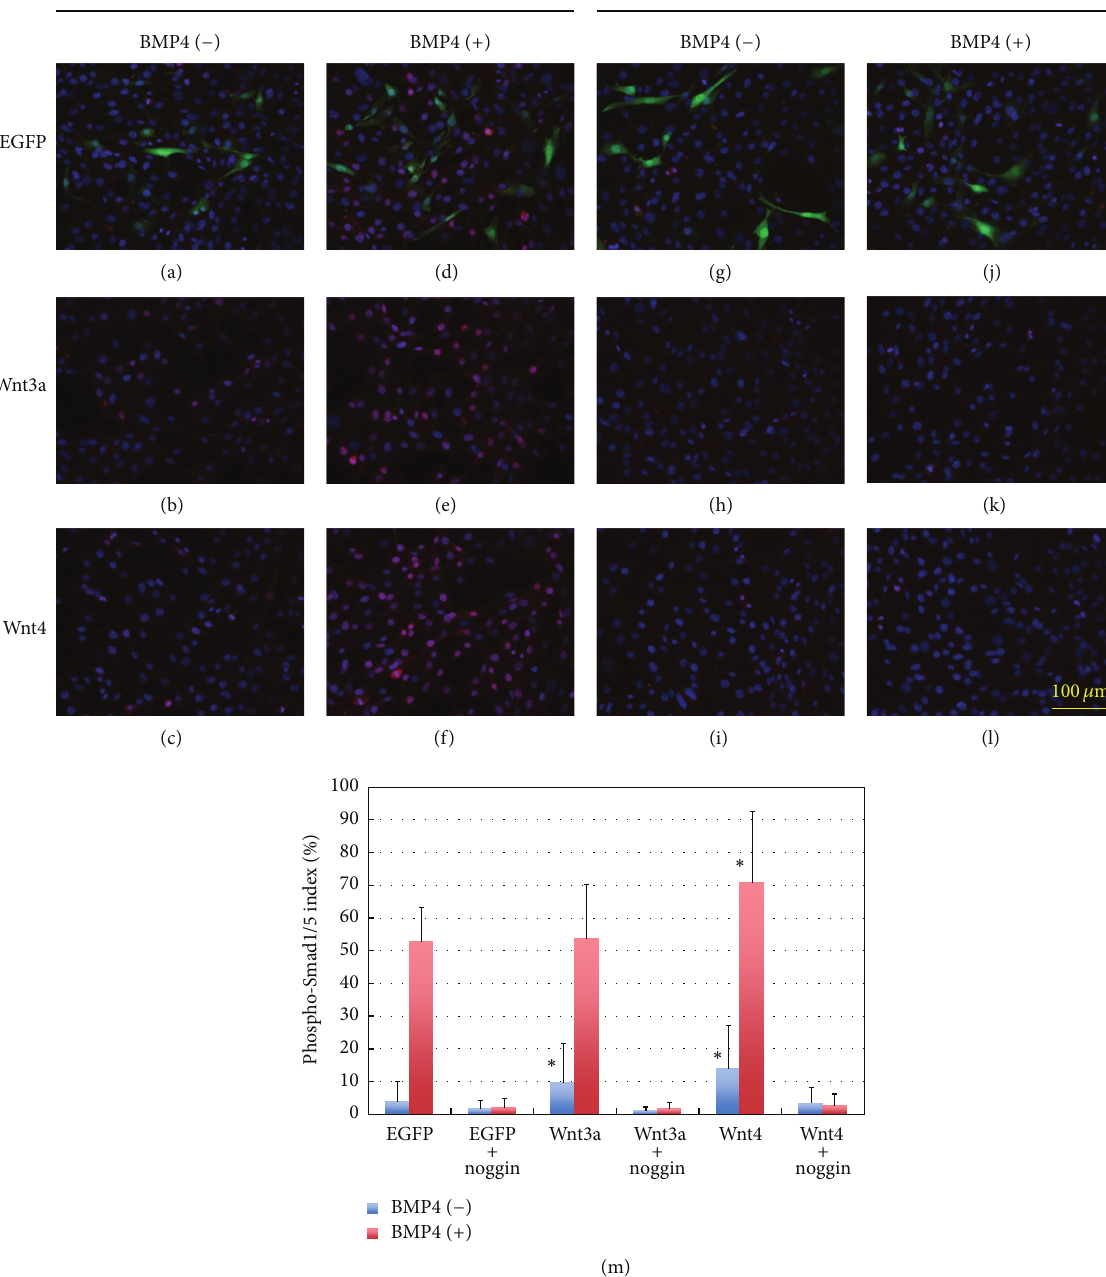
Figure 4: Effects of BMP4 and noggin on phospho-Smad1/5 expression with or without Wnt3a and Wnt4. (a–l) Recombinant adenoviruses were used to express Wnt3a , Wnt4 , or eGFP (control) uniformly in C2C12 cells. Cells were infected 48 hours earlier with an MOI of 400, and the recombinant proteins were added as shown in Figure 3 with final concentrations of 5ng/mL BMP4 and/or 250 ng/mL noggin. Two hours after BMP4 addition, immunostaining for phospho-Smad1/5 was carried out for counting. (a–c) Control; (d–f) BMP4; (g–i) noggin; (j–l) BMP4 + noggin. (m) The ratio of the nuclear phospho-Smad1/5-positive cells to the total cell number was estimated in three independent experiments counted for 6 fields each (mean + SD, 𝑛 = 18 , ∗ 𝑃 < 0.05 with Student’s 𝑡 -test). influence on BMP4/Smad signaling (Figure 4). The effects of BMP4 on phospho-Smad1/5 expression were modified by Wnt4 but not by Wnt3a (Figure 4), although Wnt3a and Wnt4 both effectively stimulated basal and endogenous Smad1/5 signaling in C2C12 cells (Figure